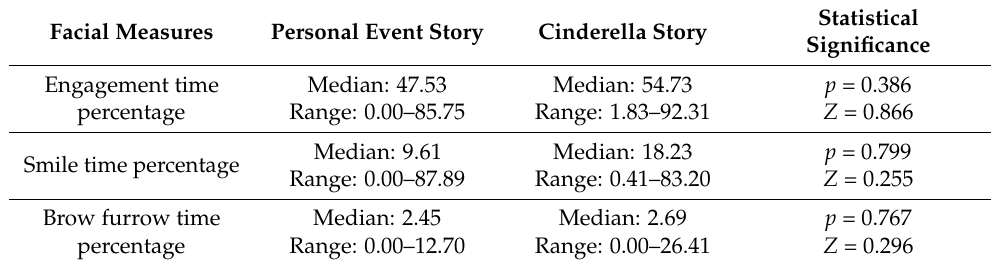
Table 8. Comparison between narrative tasks for the TBI